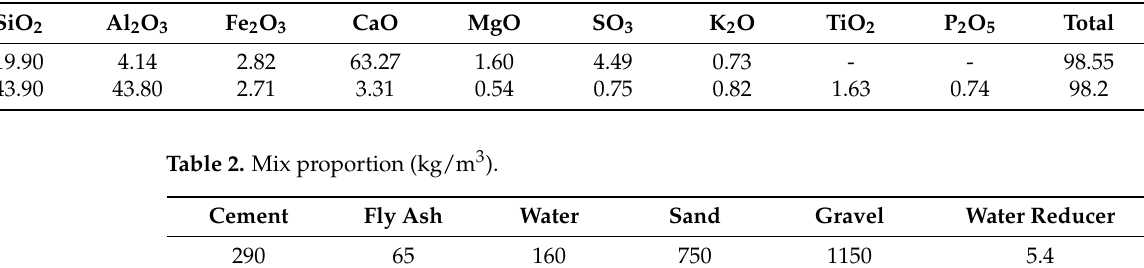
Table 1. Chemical compositions of the raw materials (wt%).